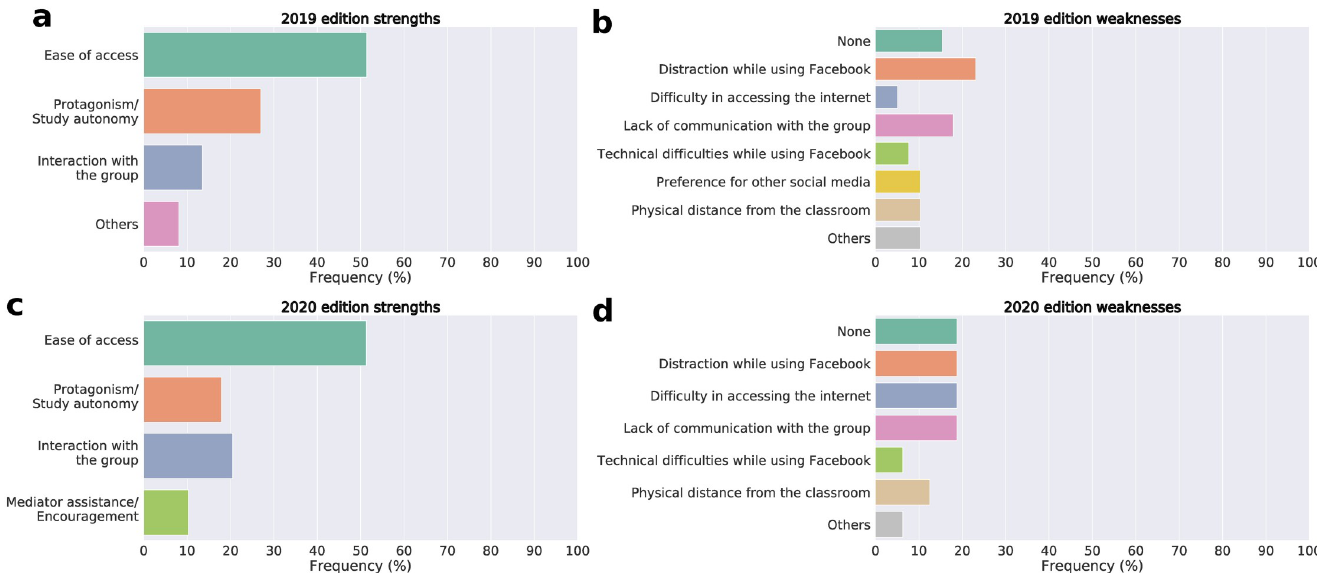
Fig 3. Students’ perceptions of the “Adopt a Microorganism” project. [a] positive points highlighted in 2019; [b] negative points highlighted in 2019; [c] positive points highlighted in 2020; [d] negative points highlighted in 2020.